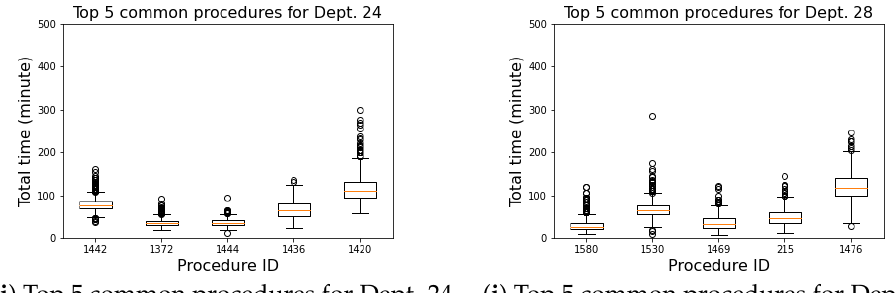
( i ) Top 5 common procedures for Dept. 24 ( j ) Top 5 common procedures for Dept. 28